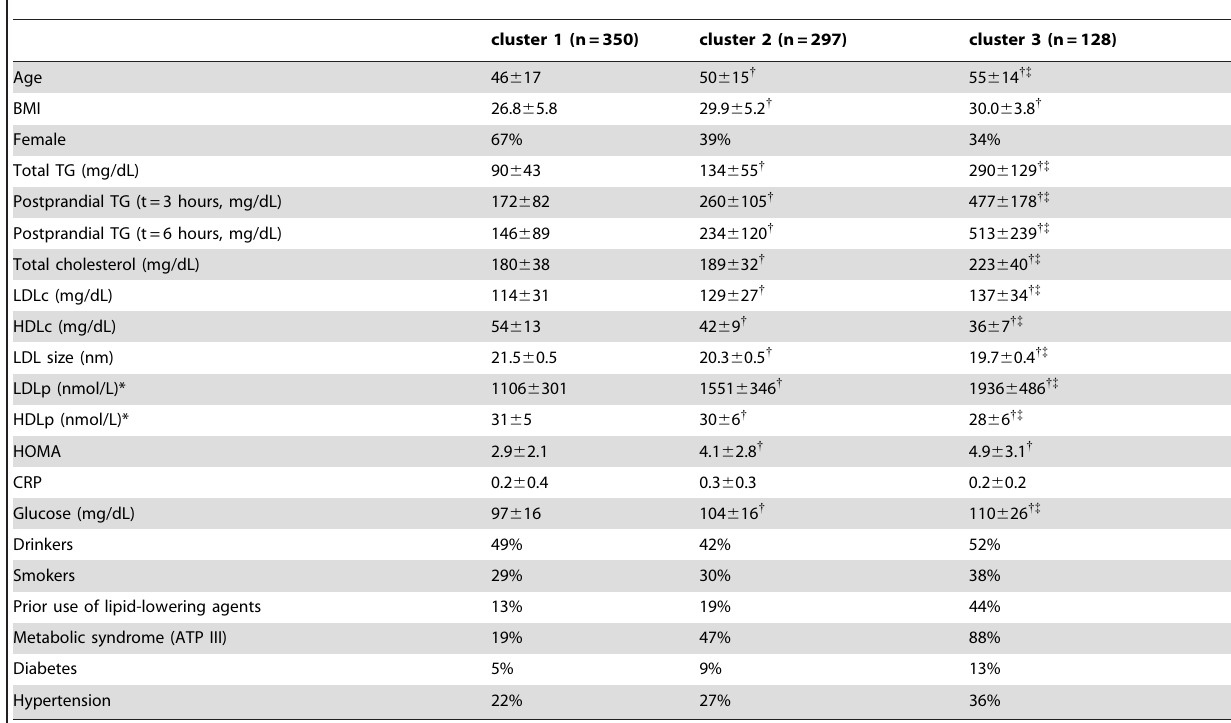
Table 1. Baseline characteristics of subjects in clustering on lipoprotein